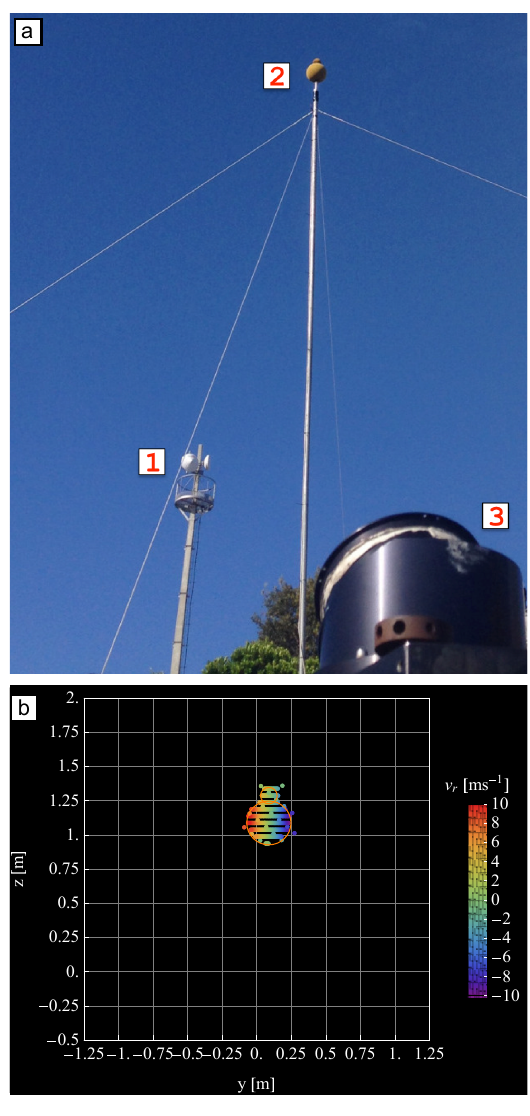
tower, 2 – calibration pole with two motor-driven balls and 3 – SRWS’s scanner head); (b) radial wind speeds induced from the rotation of the two rotating balls as measured by SR1 (the perimeter of the two balls is depicted with orange